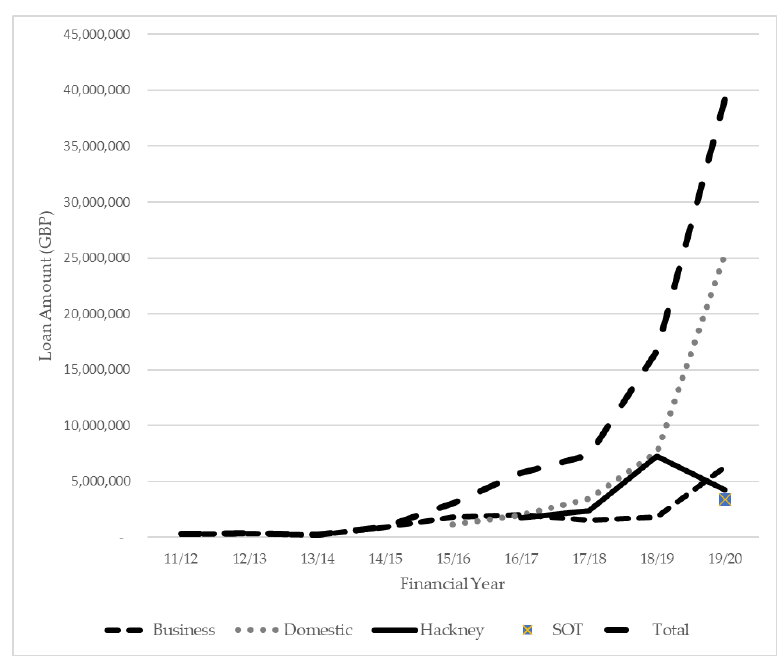
Figure 8. Scotland Low Carbon Transport Loan statistics classified by use: business, domestic, hackney and switched on taxis (SOT); SOT was launched in May 2019 (source: EST [52], as of 8 April 2020).